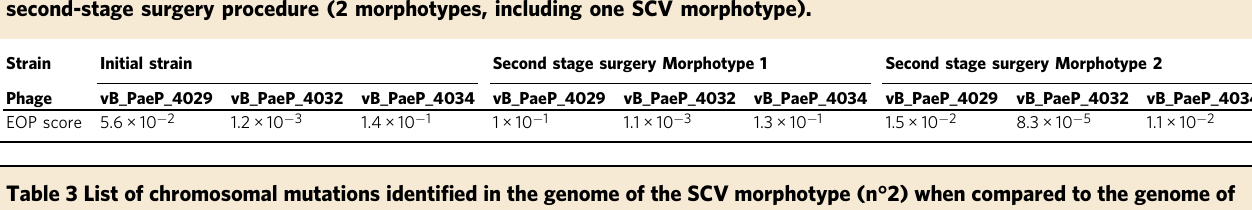
Table 3 List of chromosomal mutations identi fi ed in the genome of the SCV morphotype (n°2) when compared to the genome of morphotype n°1.